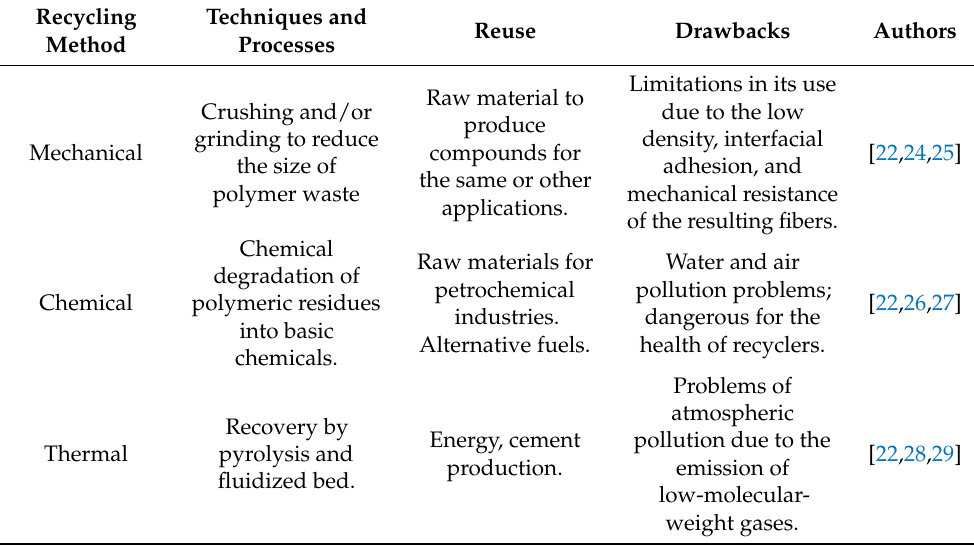
Table 1. Recycling methods, techniques, reuse, and